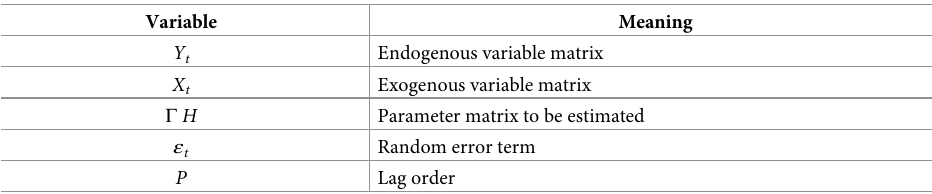
Table 3. VAR Model variable